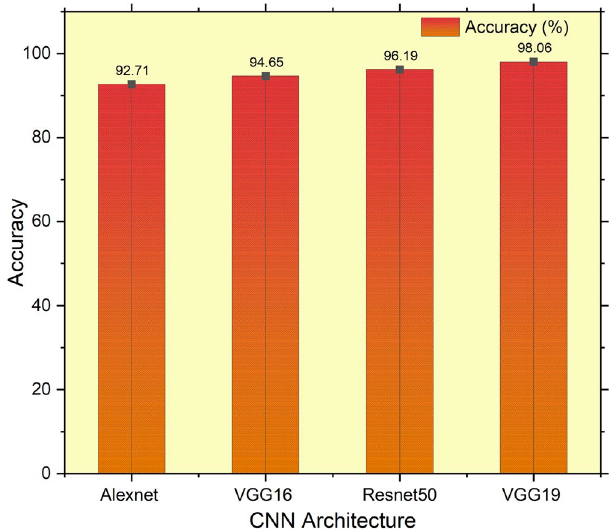
Figure 8. Comparative accuracy analysis using different CNN-based architecture.